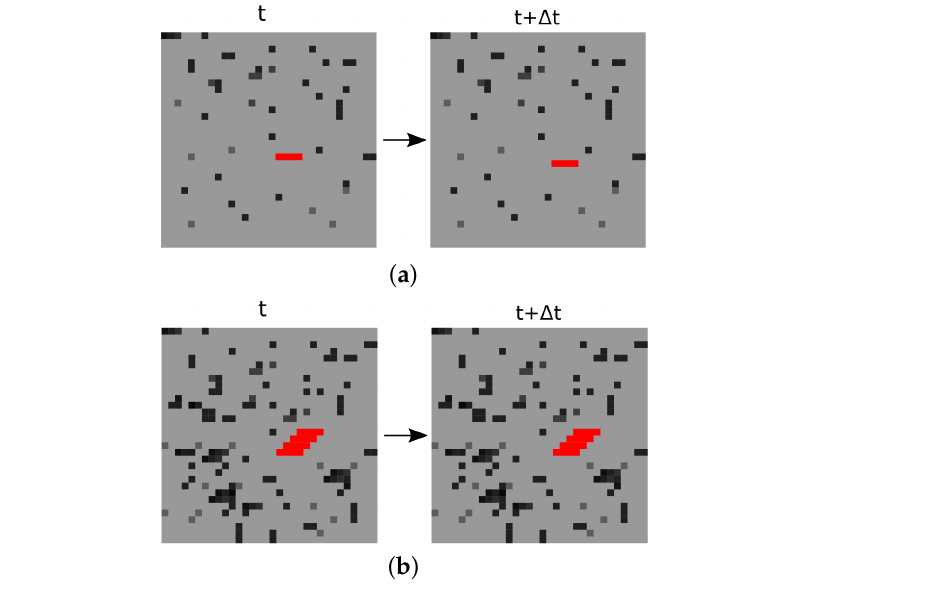
Figure 12. ( a ) Experimental example of an object size of four pixels used for comparison experiments; ( b ) experimental example of an object size of 16 pixels used for comparison experiments. Table 2. Data statistics of the comparison experiments of LDDN and GDDN, and CNN, under the static background noise.